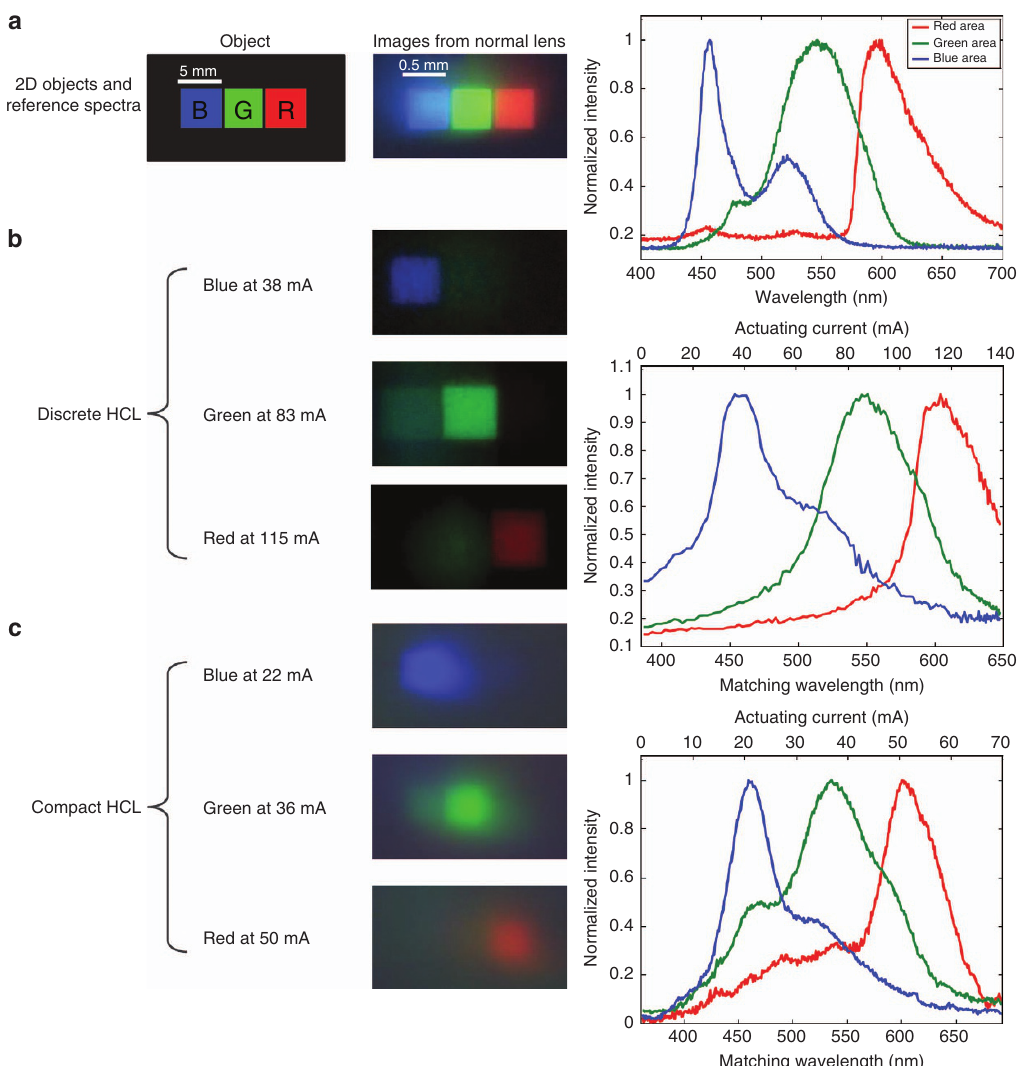
Figure 8 A two-dimensional (2D) hyperspectral measurement of an object consisting of three different colored areas. Reference spectra measured by a commercial spectrometer ( a ) and the hyperspectral images measured by the discrete HCL ( b ) and the compact HCL (c ). The measurement setup is shown in Figure 2b. On the left: the objects imaged by the hyperchromatic lenses; seen here are three images for each lens at the best focus at different actuation currents; the magni fi cation is 10:1. On the right: spectra of different areas on the object measured by the HCL; the intensity is measured in grayscale values as a function of the actuation